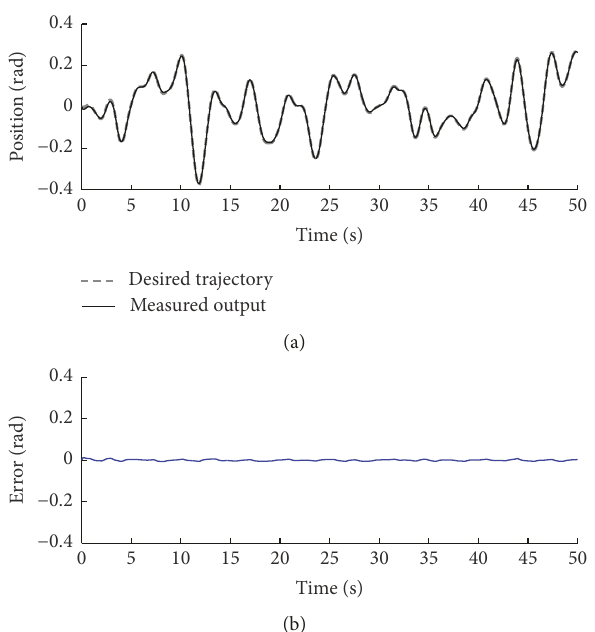
Figure 8: Simulation result of the designed adaptive laws for random trajectory